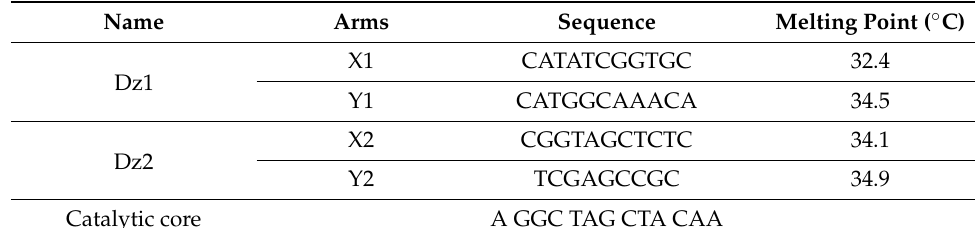
Table 1. Oligonucleotides used in the experiment.